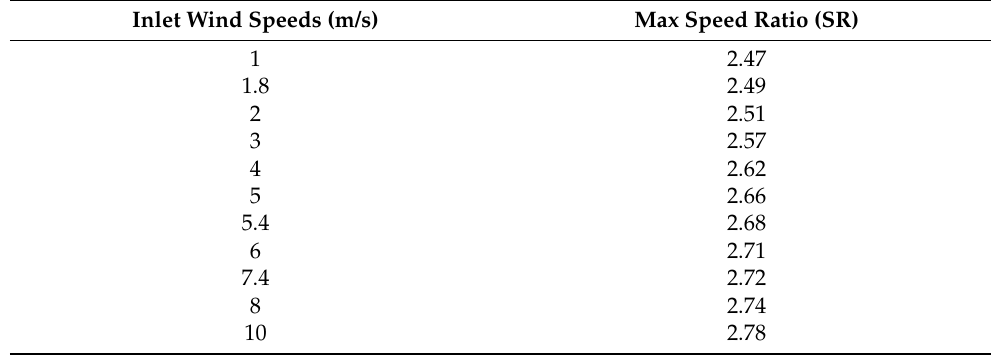
Table 3. Performance summary of the proposed omni-directional wind funnel in terms of its speed ratio (SR) under different inlet wind